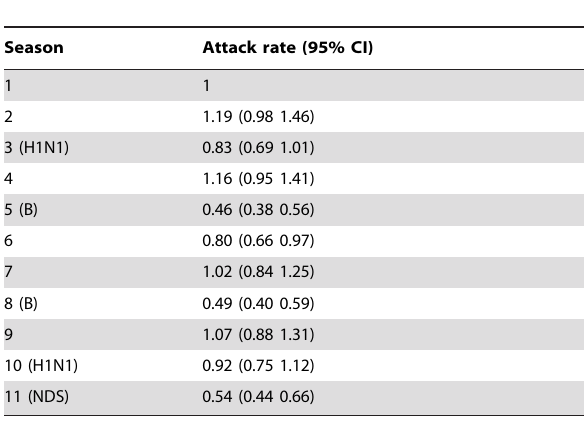
Table 1. Estimates of the RR/AR model for the attack rate of each season relative to the attack rate of season 1.